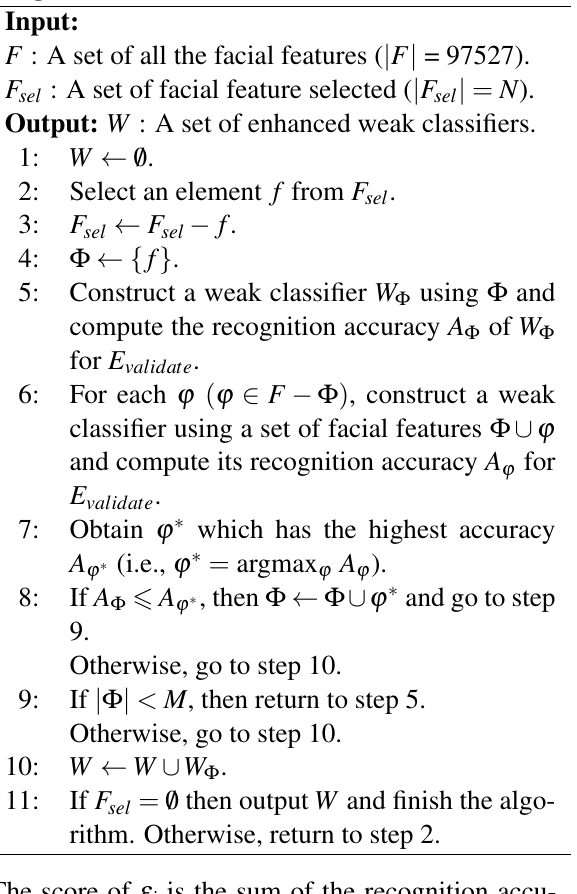
Algorithm 2 Enhancement of weak